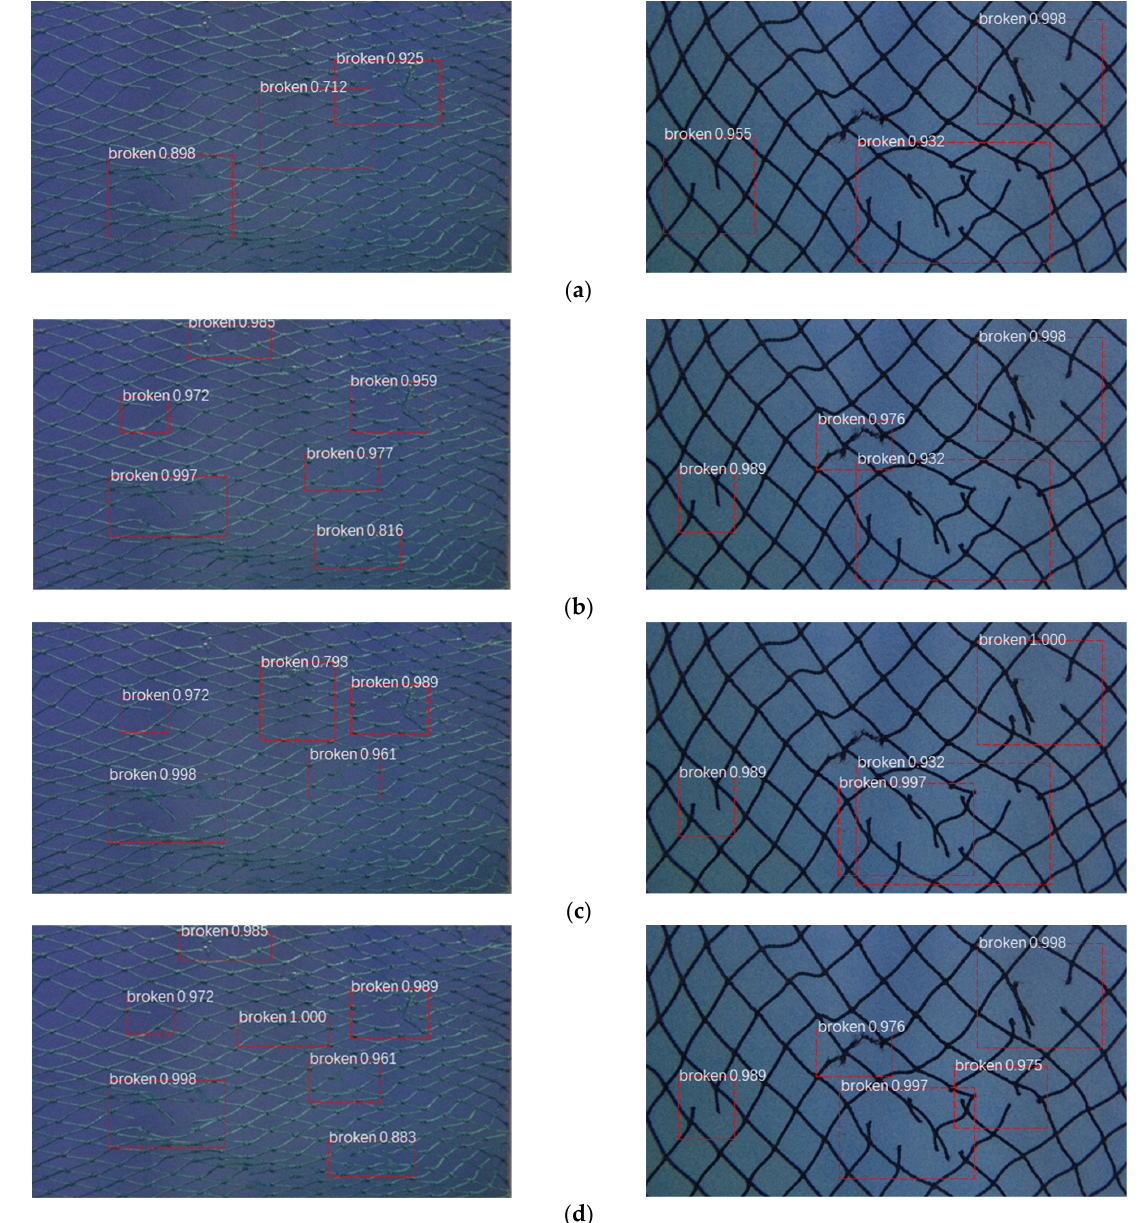
Figure 11. Netting damage detection effects of models in the ablation experiment. ( a ) Mask R-CNN, ( b ) Mask R-CNN+RFP, ( c ) Mask R-CNN+DCN, and ( d ) Mask R-CNN+RFP+DCN.